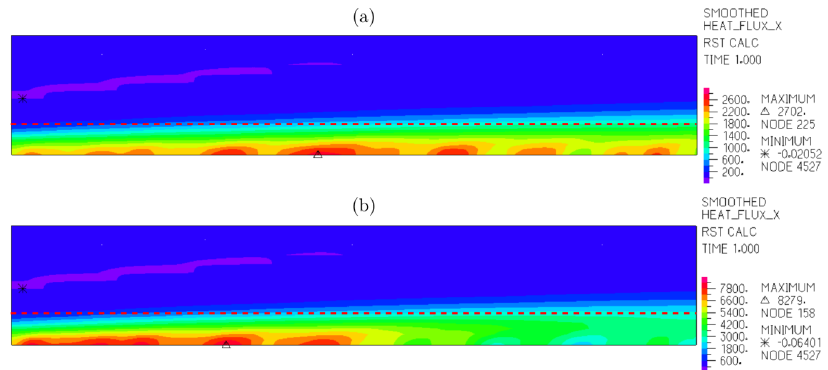
Figure 13. Distribution of heat flux in the fluid obtained from the FEM computations carried out by ADINA software; the data for the test section with five minichannels; experimental parameters listed in Table 2, heat flux values: ( a ) q’’ = 13.8 kW/m 2 ; ( b ) q’’ = 55.8 kW/m 2 . Energies 2020 , 13 , x FOR PEER REVIEW